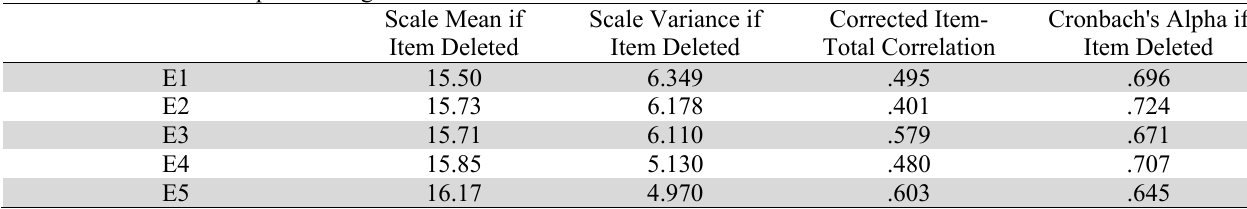
Results of Cronbach’s Alpha Testing of Attributes